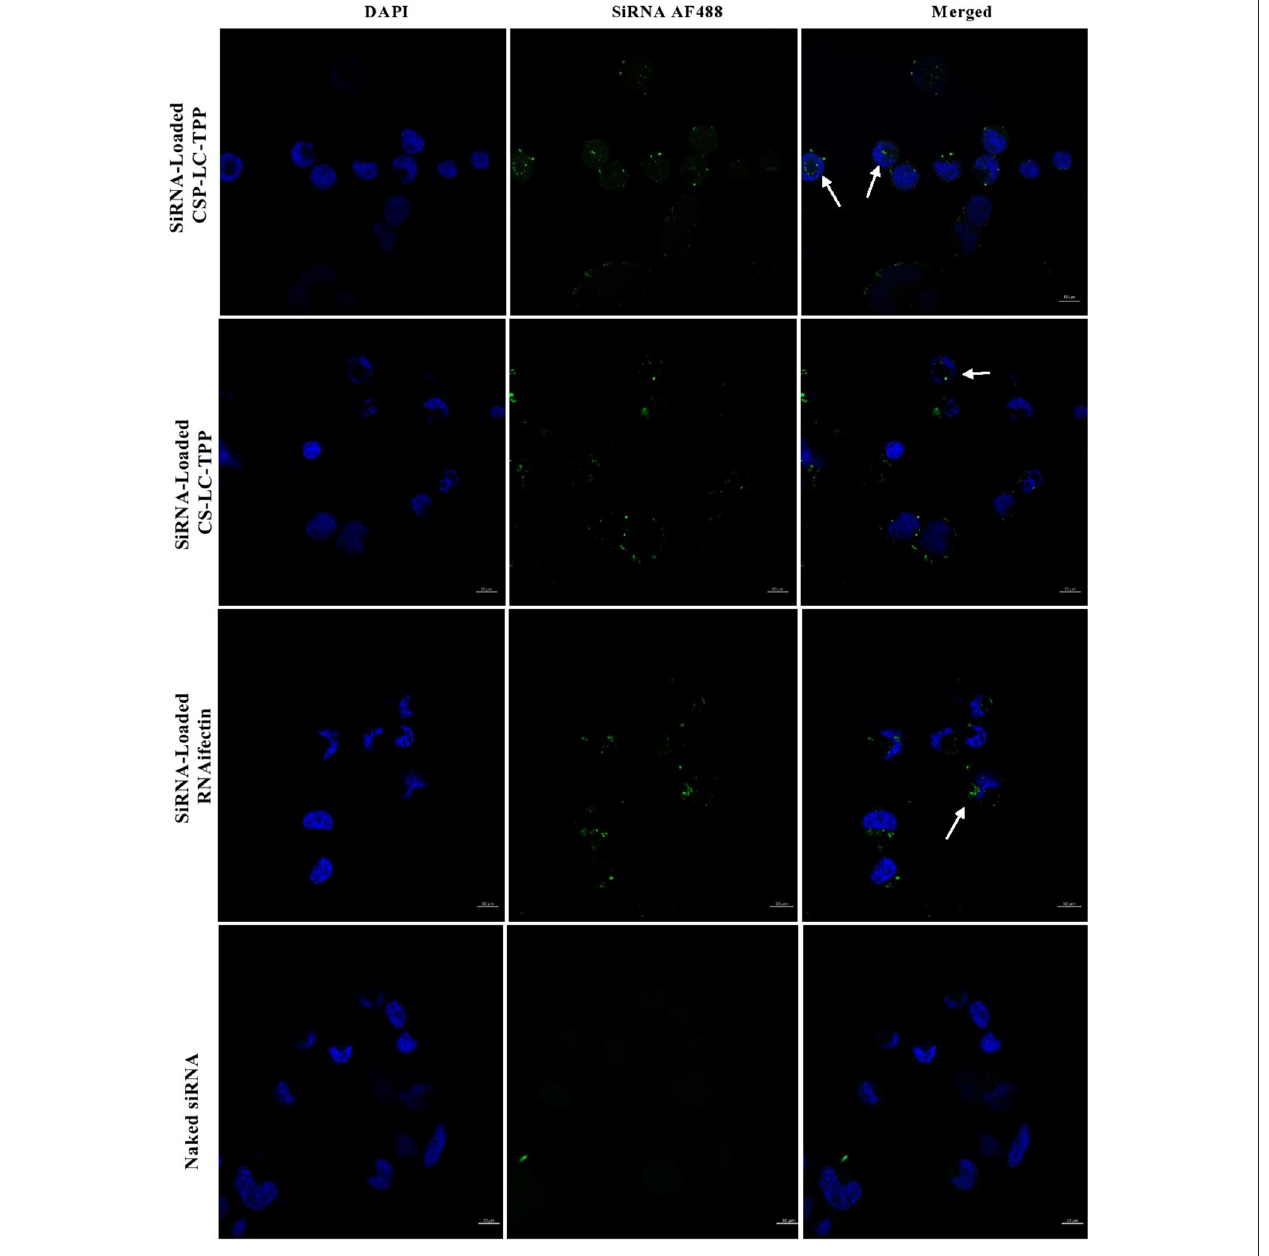
tend to complex and disrupt the cellular anionic phospholipid bilayer membrane (Shao et al., 2015). Importantly, the most efficient transfection carrier CSP-LC-TPP NPs are virtually non- cytotoxic and, therefore, very appropriate for siRNA delivery. Supplementary Figure 5 shows light microscopy images of cellular